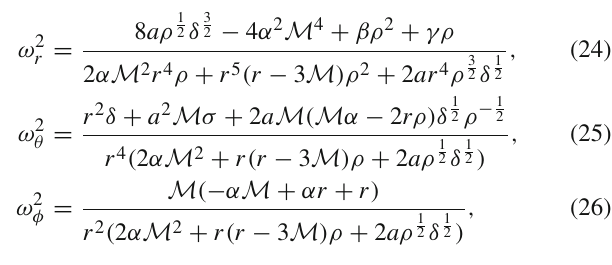
Table 1 Observed twin HF QPO data for three microquasars and the restrictions on mass and spin of the BHs located in them, based on measurements independent of the HF QPO measurements given by the optical measerument for mass estimates and by the spectral contin- uum fitting for spin estimates [31,37]. For Kerr-MOG BH we modified